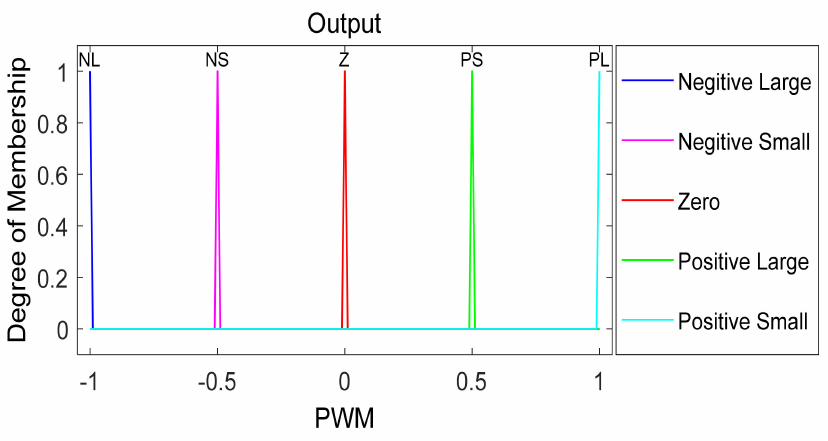
Figure 10. Output variables of membership